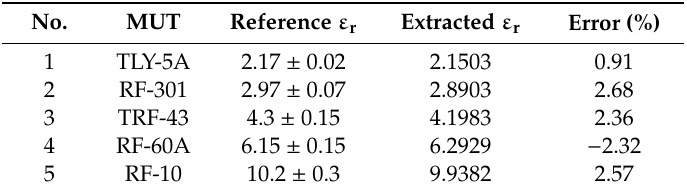
Table 5. Comparison of extracted relative permittivity for the five